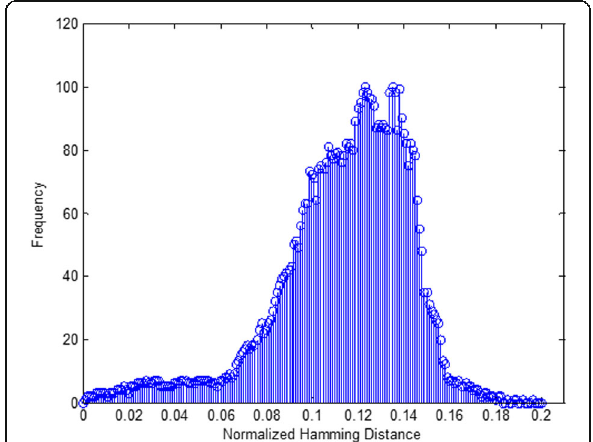
Fig. 7 The histogram of the normalized hamming distance for perceptual similar image